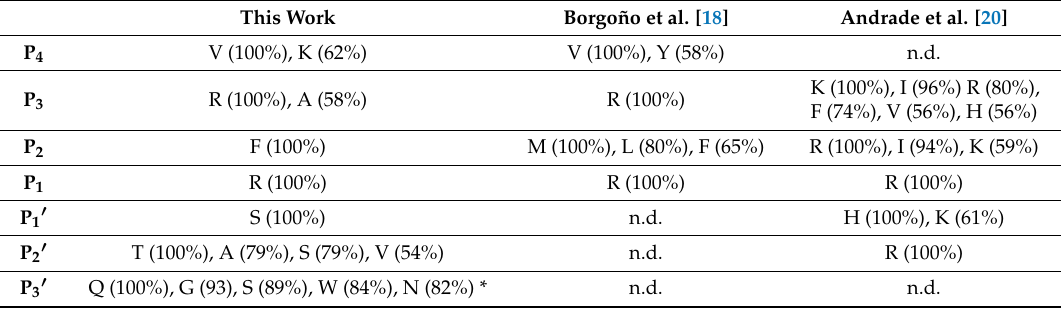
Table 1. Summary of P 4 -P 3 (cid:48) residues most preferred by kallikrein 13 (KLK13) as determined by this and prior studies. All percentage values were calculated and compared from each publication separately. Activity on the most preferred residue was considered as 100% and the following amino acids were then adjusted accordingly to the highest value for each position. Only amino acids with a threshold over 50% are listed, with the exception of the P 3 (cid:48) values where an 80% threshold was used due to low selectivity at that position (*). n.d.—not